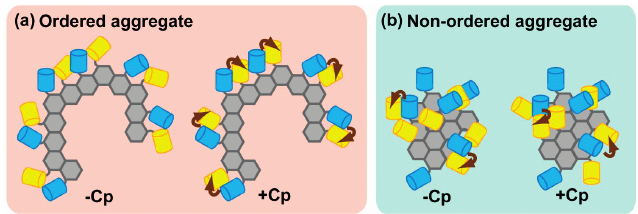
Figure 3. A schematic diagram of modulation of Förster/Fluorescence Resonance Energy Transfer (FRET) efficiency in ordered or non-ordered aggregates using fluorescent proteins. Cyan and yellow barrels show the fluorescent protein as a donor or acceptor, respectively; gray hexagons represent individual units of misfolded proteins; and brown arrows indicate efficient energy transfer. ( a ) In ordered aggregates, introduction of circular permutation (+Cp) dramatically affects FRET efficiency; ( b ) In non-ordered and amorphous aggregates, +Cp barely affects FRET